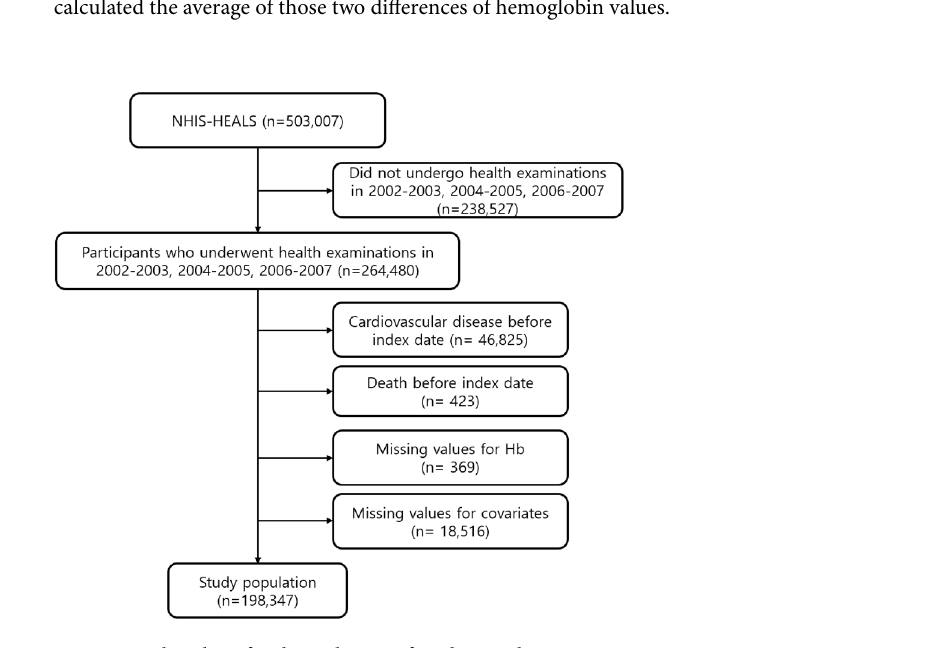
Figure 1. Flowchart for the inclusion of study